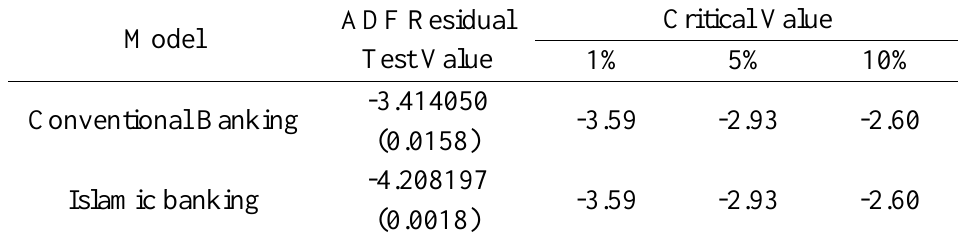
Table 4. Conventional and Islamic Banking Cointegration Test